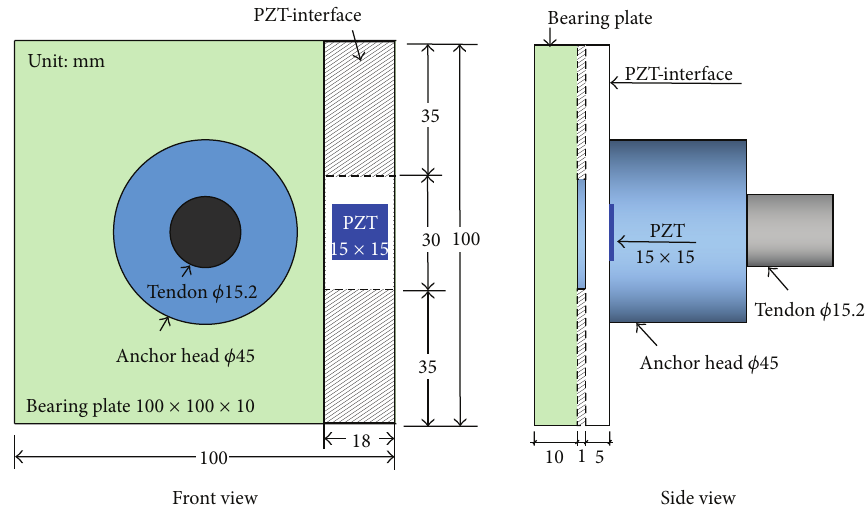
Figure 5: Geometry of lab-scaled tendon-anchorage equipped with PZT-interface [13].